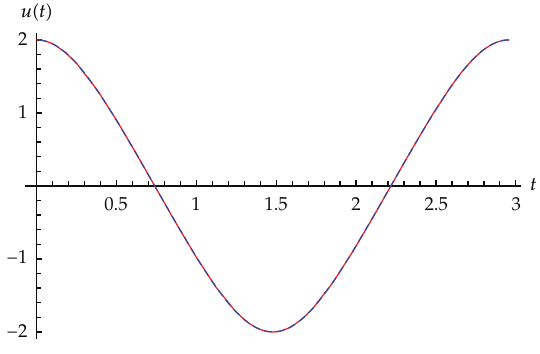
Figure 4: Comparison between the approximate solution (cid:2) 2.34 (cid:3) and numerical solution of (cid:2) 2.13 (cid:3) in Case b: a (cid:9) b (cid:9) 1 , A (cid:9) 2: dashed red line: numerical solution, dashed blue line approximate solution.